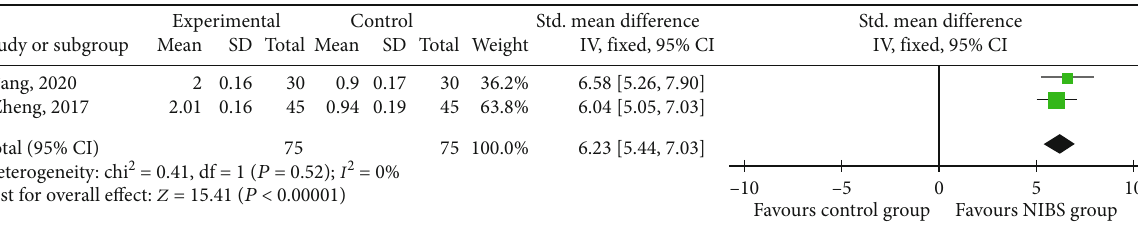
Figure 7: E ff ects of NIBS on WST scores of patients with dysphagia after